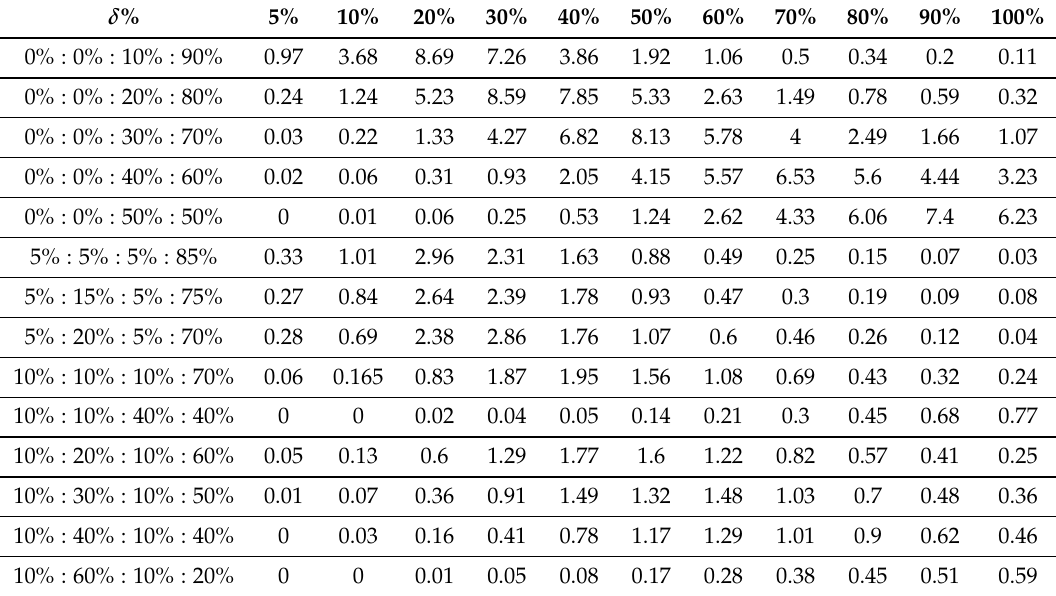
Table 3. Average percentages of the instances whose optimality of the constructed permutations was proven at the on-line phase of